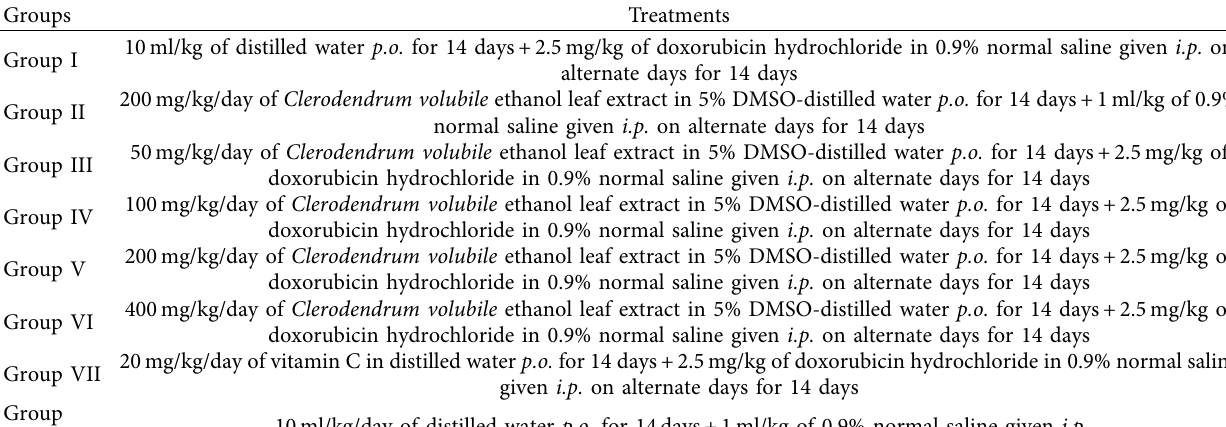
Table 1: Group treatment of